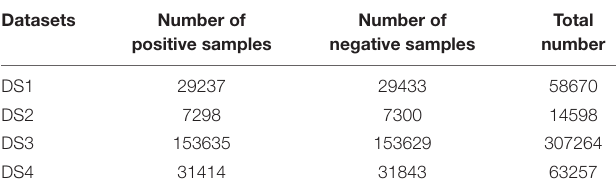
TABLE 1 | Number of samples in each